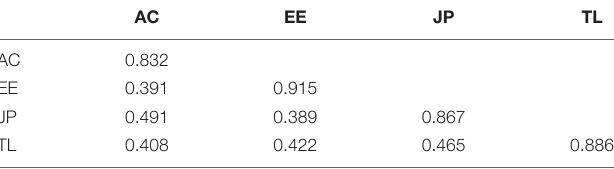
TABLE 2 | Table Fornell–Larcker